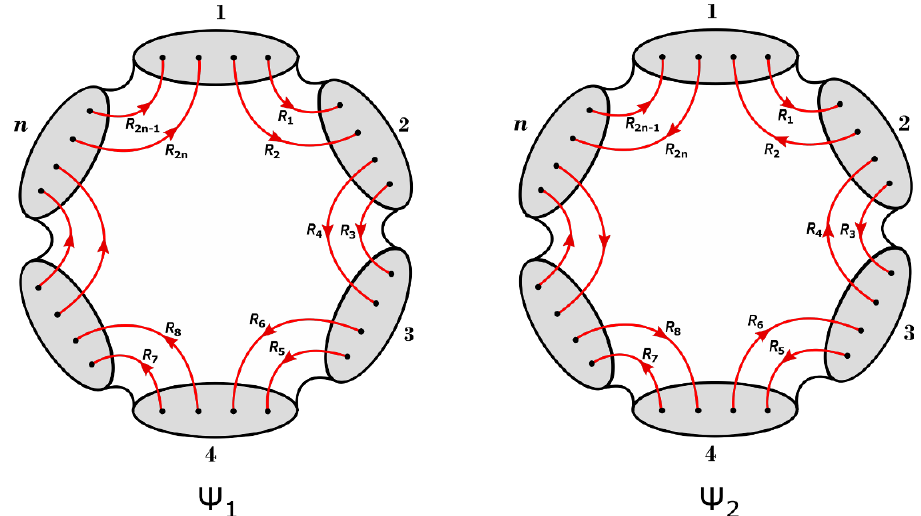
Figure 7 . Manifold with n number of S 2 boundaries. Each S 2 has four punctures. Wilson lines are threaded from one boundary to another without any